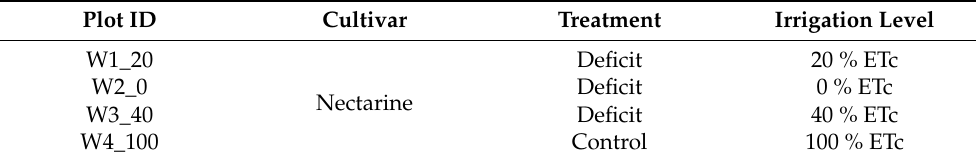
Table 1. Summary of irrigation levels applied to control and treatment plots. Plot ID